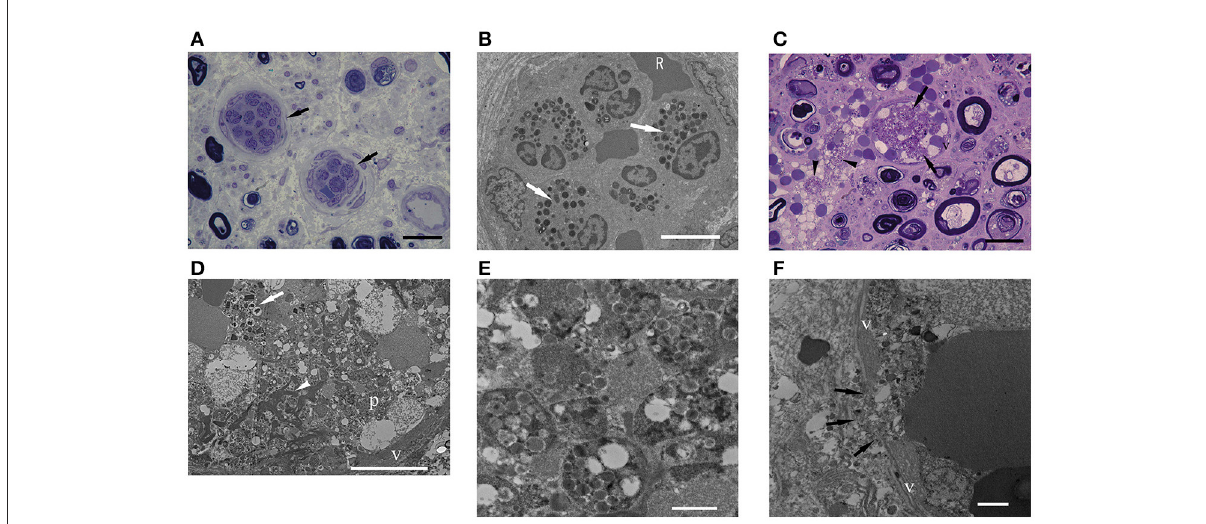
FIGURE4 Intraluminal eosinophils. (A,C) EPON-embedded section with toluidine-blue staining. (B,D–F) Electron microscopy findings. (A,B) Intraluminal stenosis by accumulation of eosinophils in a patient with iHES. (C–F) ANCA-negative EGPA. (A) The percentages of intraluminal areas occupied by eosinophils: 60% (left arrow) and 62% (right arrow). (B) Electron microscopy showed that most of the vascular lumen was occluded by eosinophils and red blood cells. (C) Endoneurial vessel occluded by eosinophils (arrows). Infiltration of eosinophils into the extravascular space (arrowhead) and active axonal degeneration of myelinated nerve fibers is observed. (D) The occluded vessel in (C) occupied by eosinophils (arrow), fibrin (arrowhead), platelets (p), and red blood cells. Eosinophils showed characteristic crystalloid structures, although some granular contents were lost or swollen. (E) Platelet aggregates (D) are shown. (F) Endoneurial vessel destruction (arrows) by cytolytic eosinophil are observed in ANCA-negative EGPA. Scale bars: 20 µ m (A,C) , 10 µ m (B,D) , and 1 µ m (E,F) . ANCA, anti-neutrophil cytoplasmic antibodies;